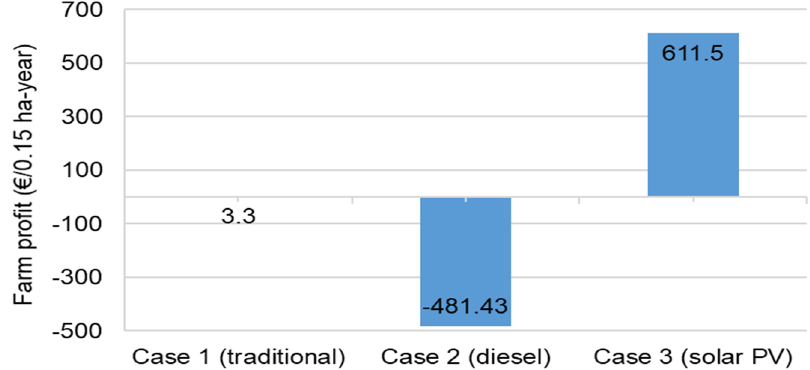
Figure 4. Gross margin for a reference farmer in a year (from 0.15 ha land).